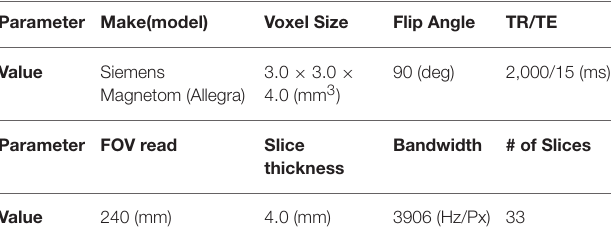
TABLE 2 | The rs-fMRI acquisition